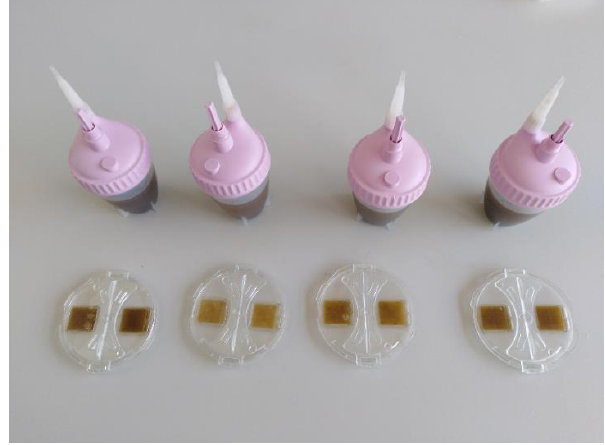
Figure 2. Mini-FLOTAC and Fill-FLOTAC devices used for quantitative coprology